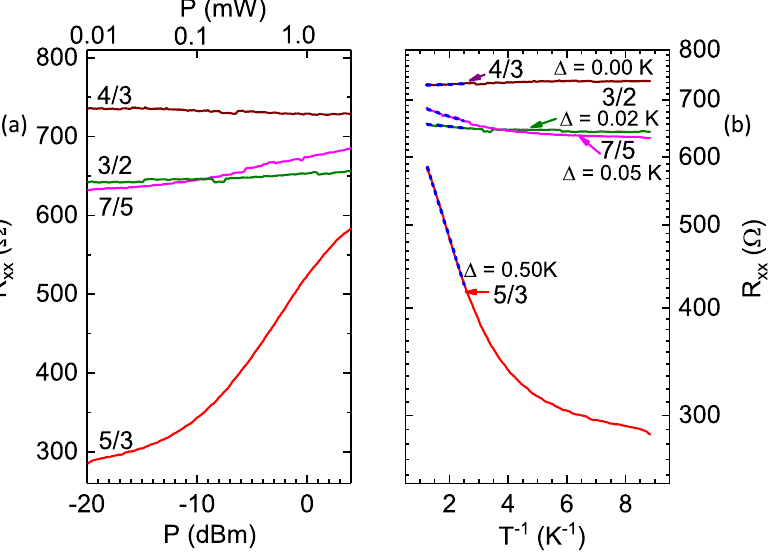
Figure 8. Extraction of activation energy. ( a ) R xx vs P traces obtained at the indicated filling factors with the chip carrier held at base temperature. The panel ( a ) shows the results for filling factors ν = 5 / 3 , 4/3, 7/5, and 3/2. ( b )Here, the abscissa P of panel ( a ) has been converted to the the inverse temperature T − 1 using the calibration exhibited in the Fig. 7(c). An activation fit, which is indicated by the dashed blue line, is shown for each trace. Note that the activation energy (cid:31) vanishes for filling factor 4/3, indicating a gapless metallic state at 4/3 at a tilt angle θ = 66 0 . This feature is consistent with the absence of the FQHE resistance minimum at ν = 4 / 3 in Fig. 6 (b) and